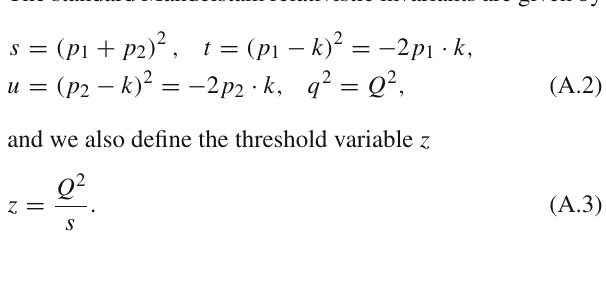
tonic production channels and by summing over all of